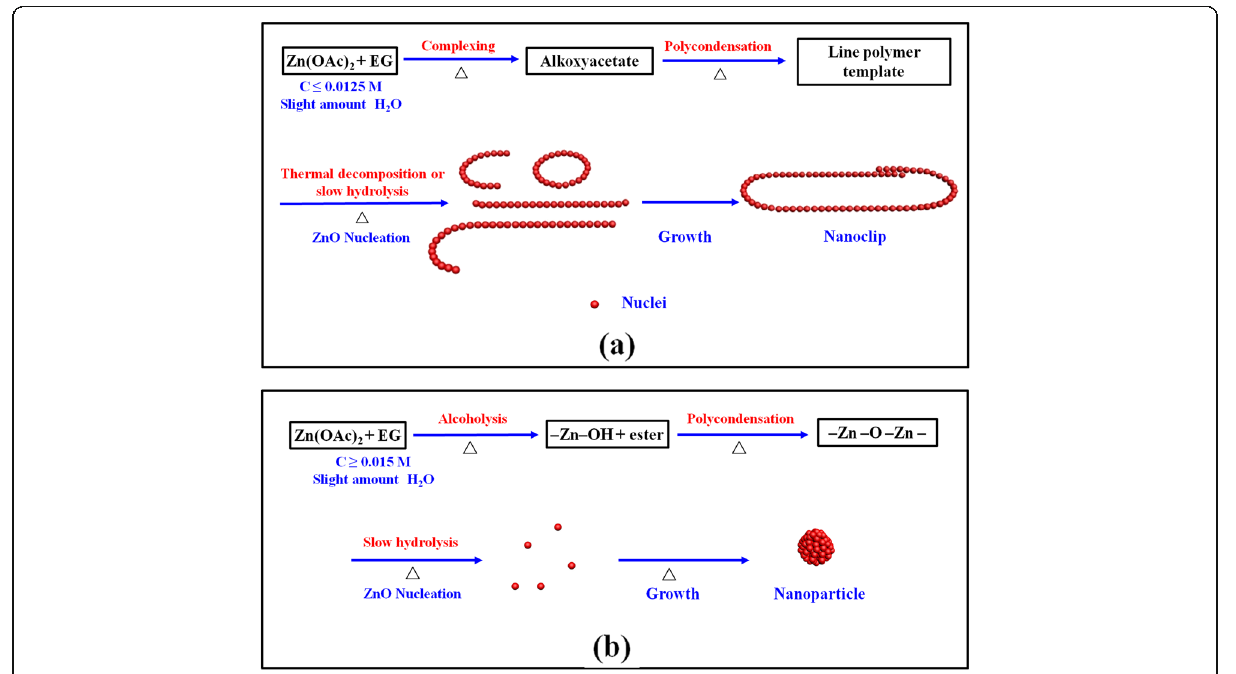
Fig. 5 Evolution schematics of ( a) ZnO nano-clip and ( b ) ZnO particle formation by two possible polyol-mediated